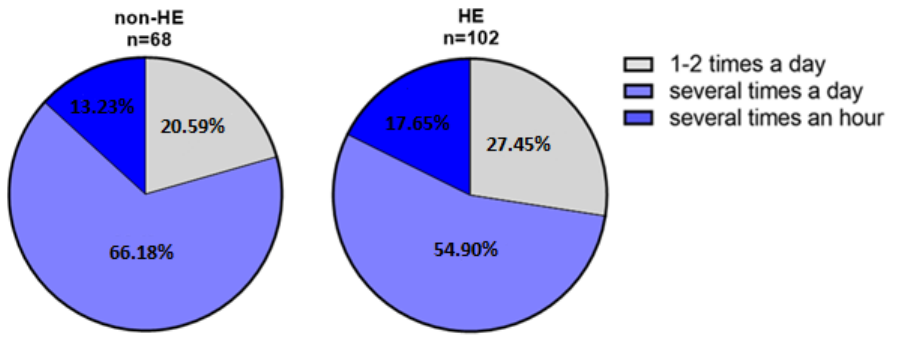
Figure 17. Percentage distribution of hand disinfection frequency in both groups during the pandemic.